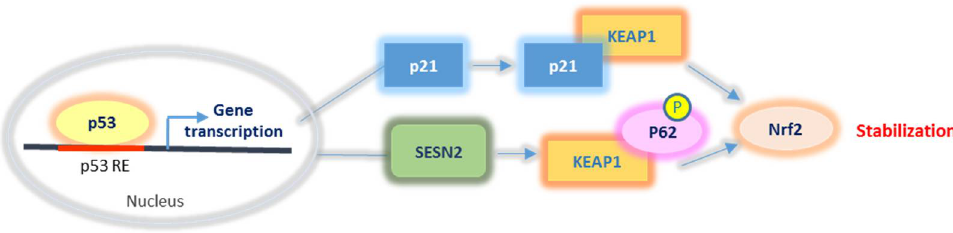
Figure 4. The effects of p53 on Nrf2. P53 contributes to Nrf2 stabilization by promoting the expression of p21/WAF1, which sequesters Keap1, thus promoting Nrf2 release and activation. P53 also promotes sestrin 2 (SESN2) gene transcription. SESN2 stimulates Keap1 degradation via the selective autophagy mediator p62 thus contributing to Nrf2 stabilization.